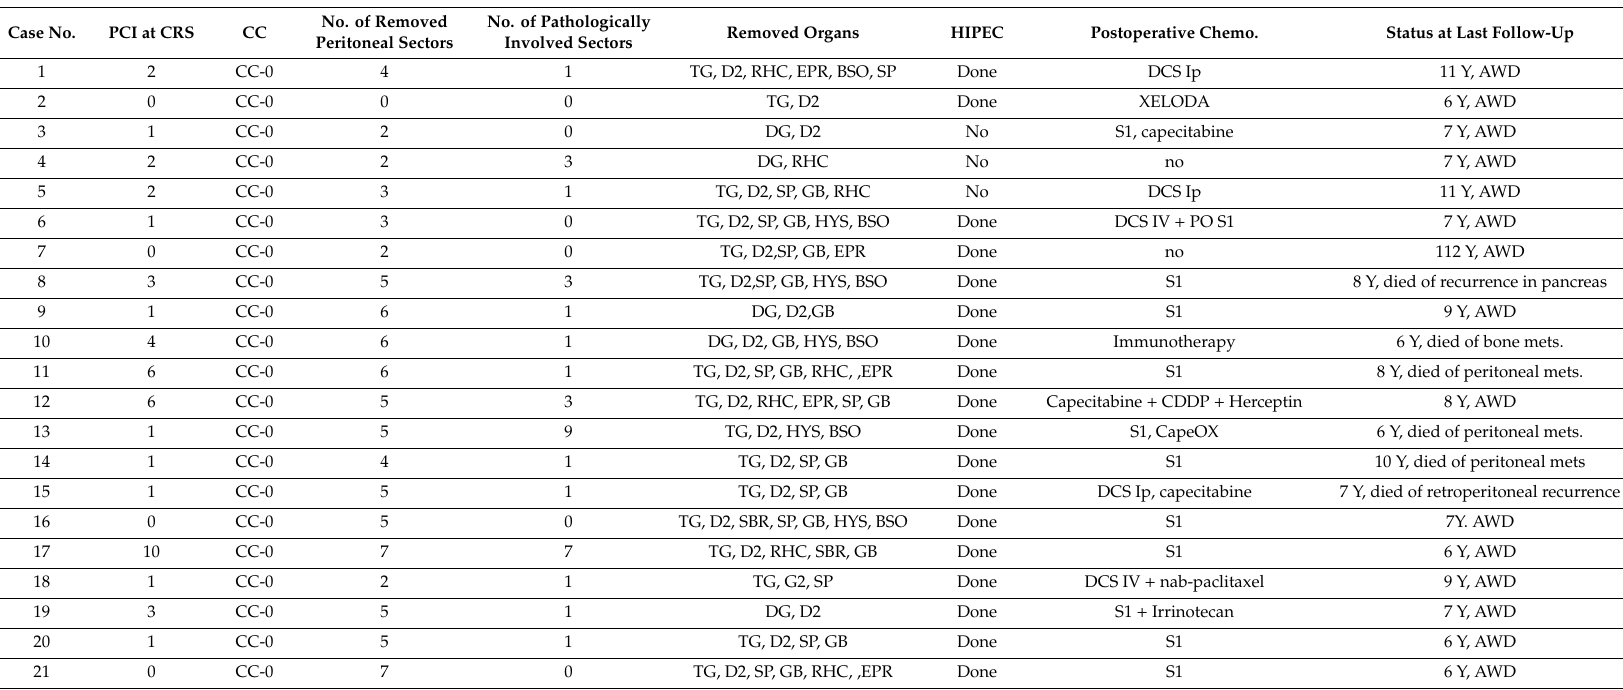
Table 5. operative details, hyperthermic intraperitoneal chemoperfusion (HIPEC), postoperative chemotherapy and outcome of 5-year survivors. Case